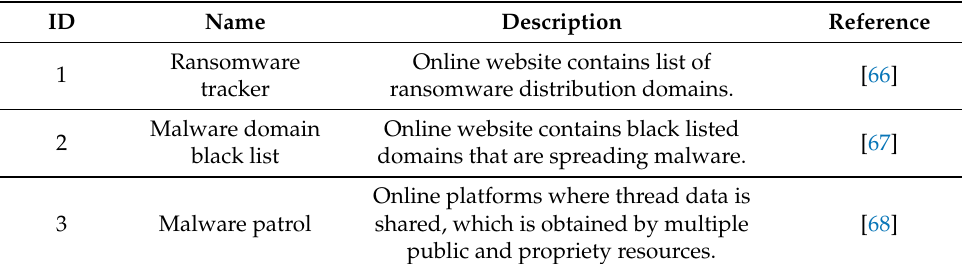
Table 15. Tools used for OSINT for malware tracking.